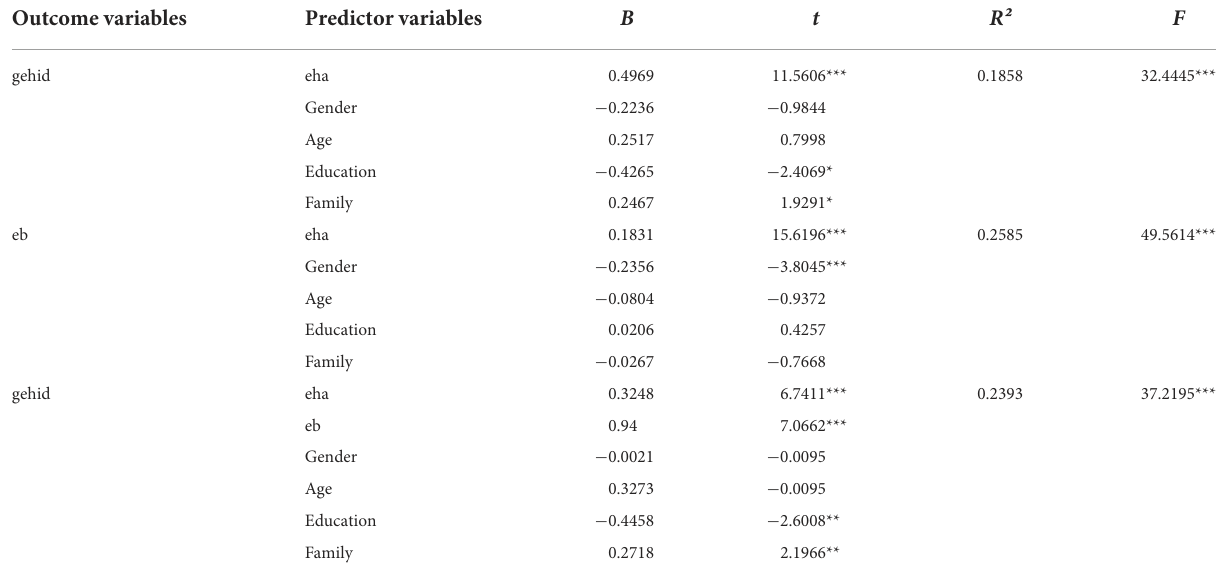
TABLE 8 Regression results.